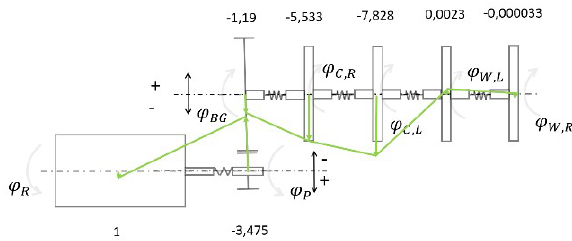
Figure 13. Fourth natural mode of torsion oscilla- tions